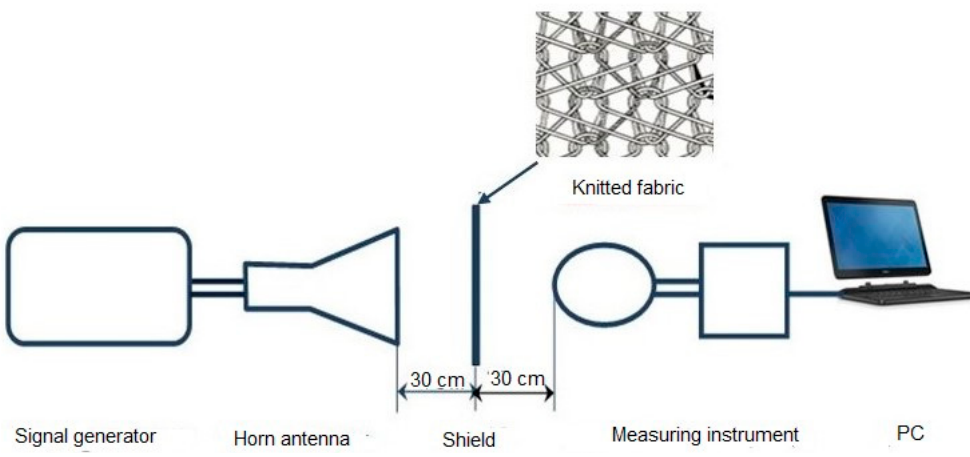
Figure 3. Schematic representation of the measurement setup.